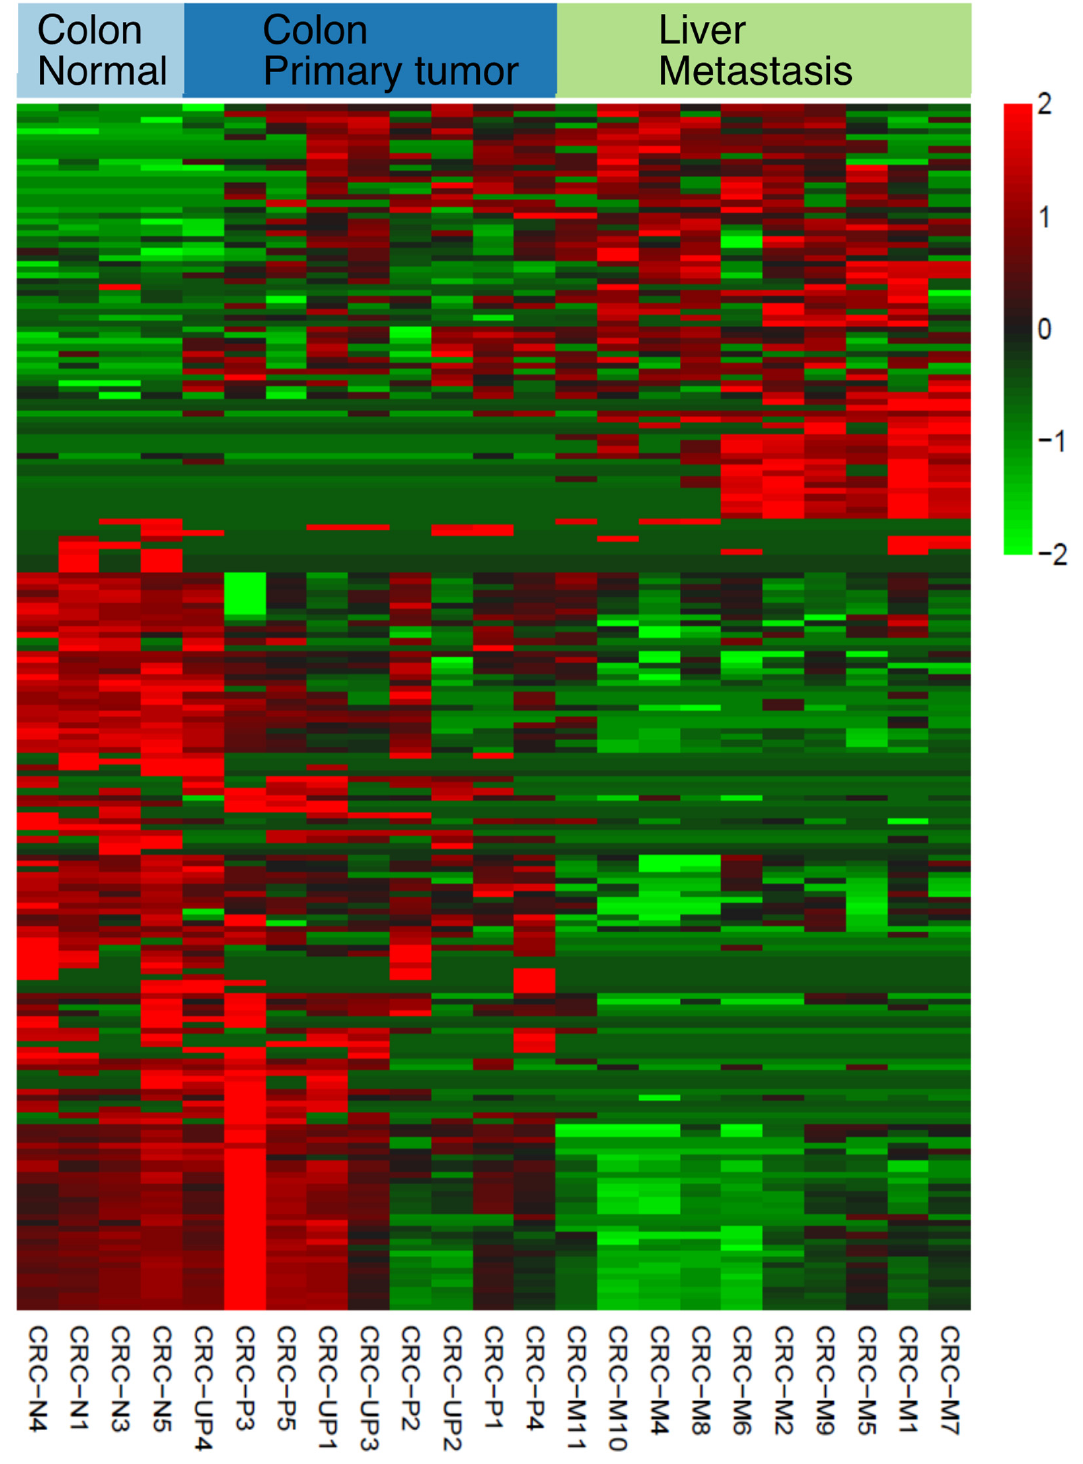
Figure 3. Differentially expressed (DE) small noncoding RNAs in colorectal cancer. Pairwise com- parisons were performed for primary colon cancer, metastasis cancer, and adjacent primary colon samples (Table S4). The heatmap shows 204 DE small RNAs detected in at least two comparisons. Fold changes, significance levels, and expression levels can also be found in Table S4. N stands for normal colon, P stands for primary colon, UP stands for unpaired primary colon (no adjacent normal sample collected), and M stands for metastasis at liver. Normal liver samples were used to filter tissue specific DE genes between the two